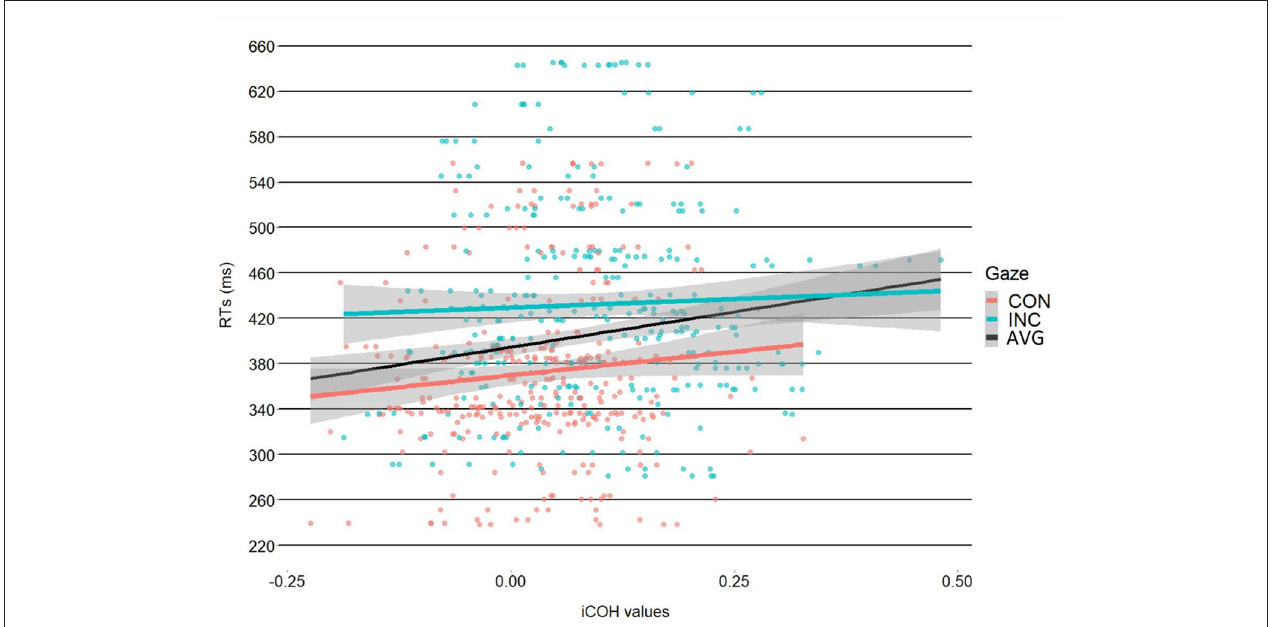
FIGURE 3 | Correlation between coherence and RTs. The graph illustrates the differences in slopes between congruent (red slope) and incongruent (blue slope), with a more positive relationship between coherence and RT for congruent vs. incongruent trials. The black slope illustrates the coherence-RT relationship regardless of gaze condition. The shaded regions illustrate the 95%